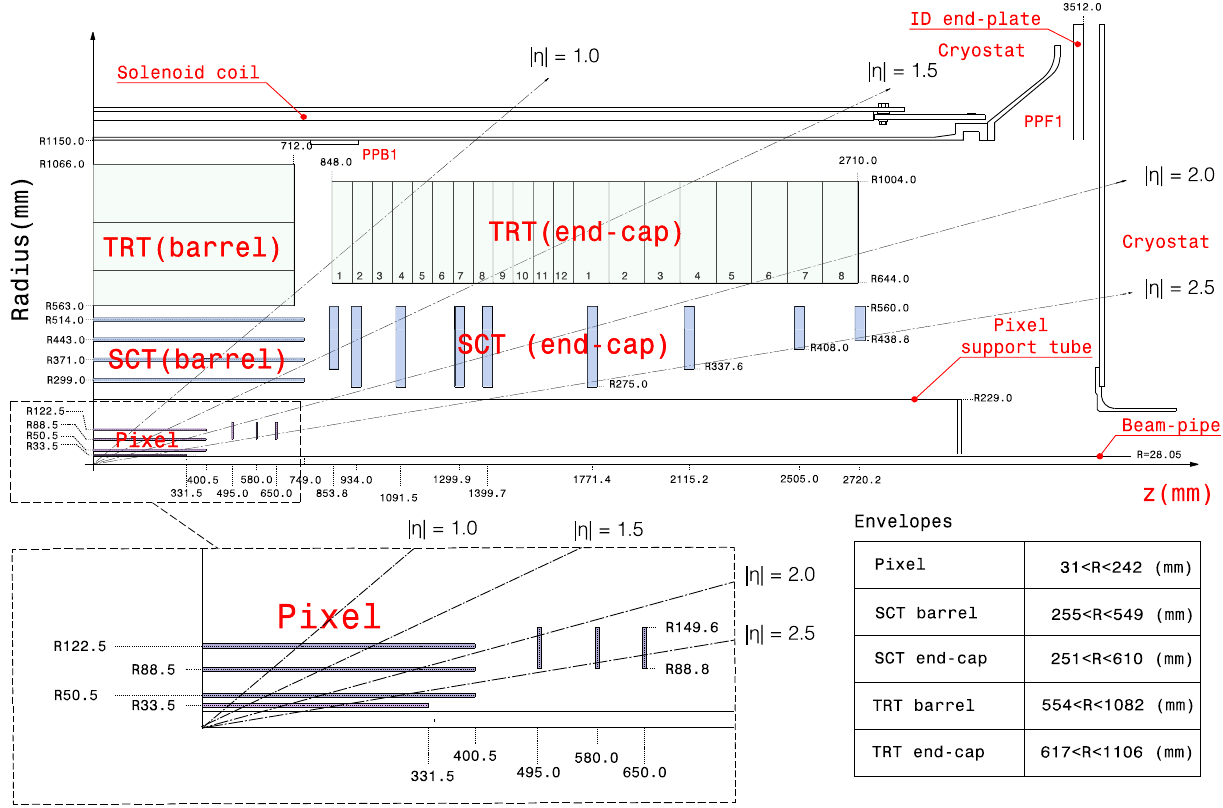
Fig. 1 A cross section of one quadrant of the ATLAS inner detector, showing the pixel, SCT and TRT barrel and endcap sections. The pixel detector includes the insertable